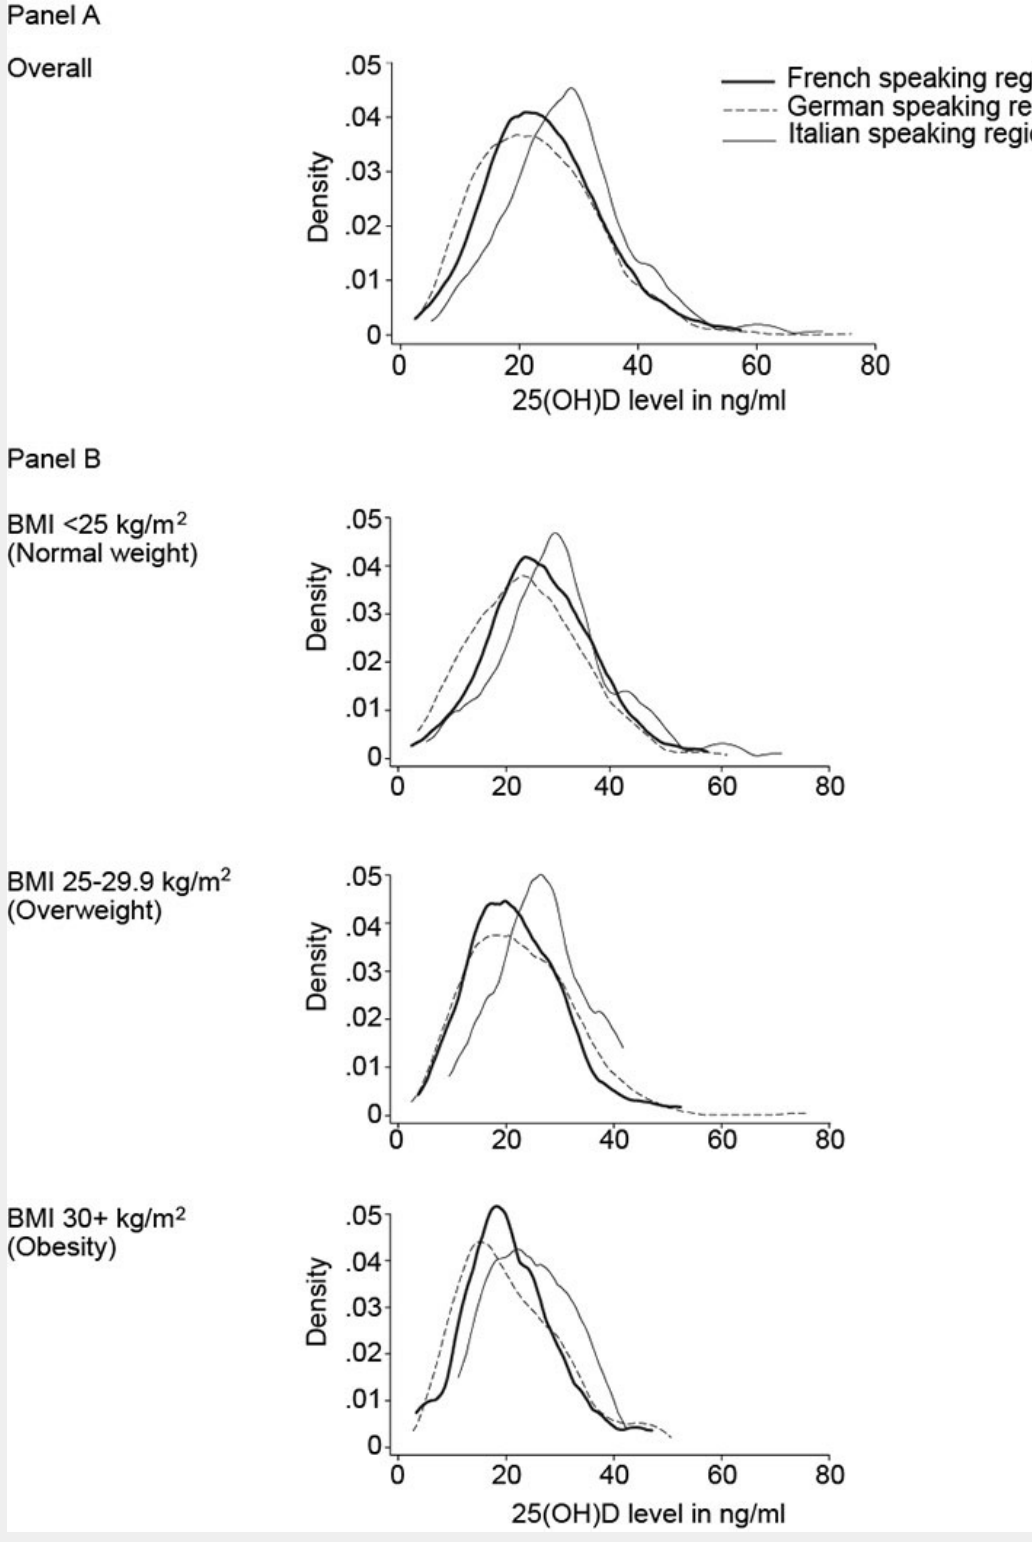
Figure 2b B 25(OH)D distribution by speaking regions, stratified by BMI